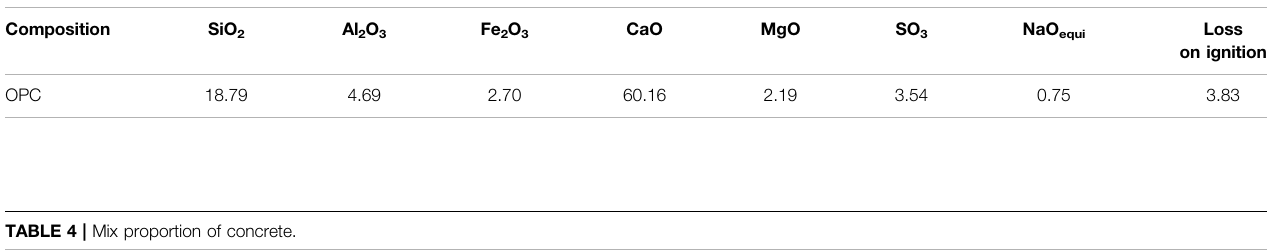
TABLE 3 | Chemical composition of cement